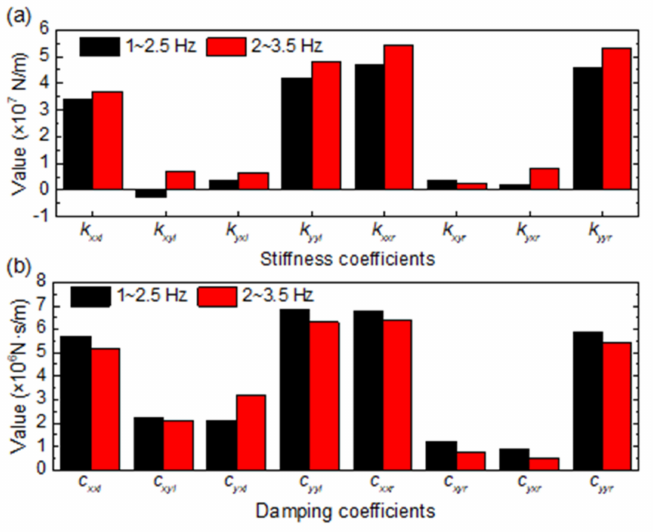
Figure 12. Relationship between dynamic characteristic coefficients of bearing and excitation fre- quency: ( a ) stiffness coefficients; ( b ) damping coefficients.